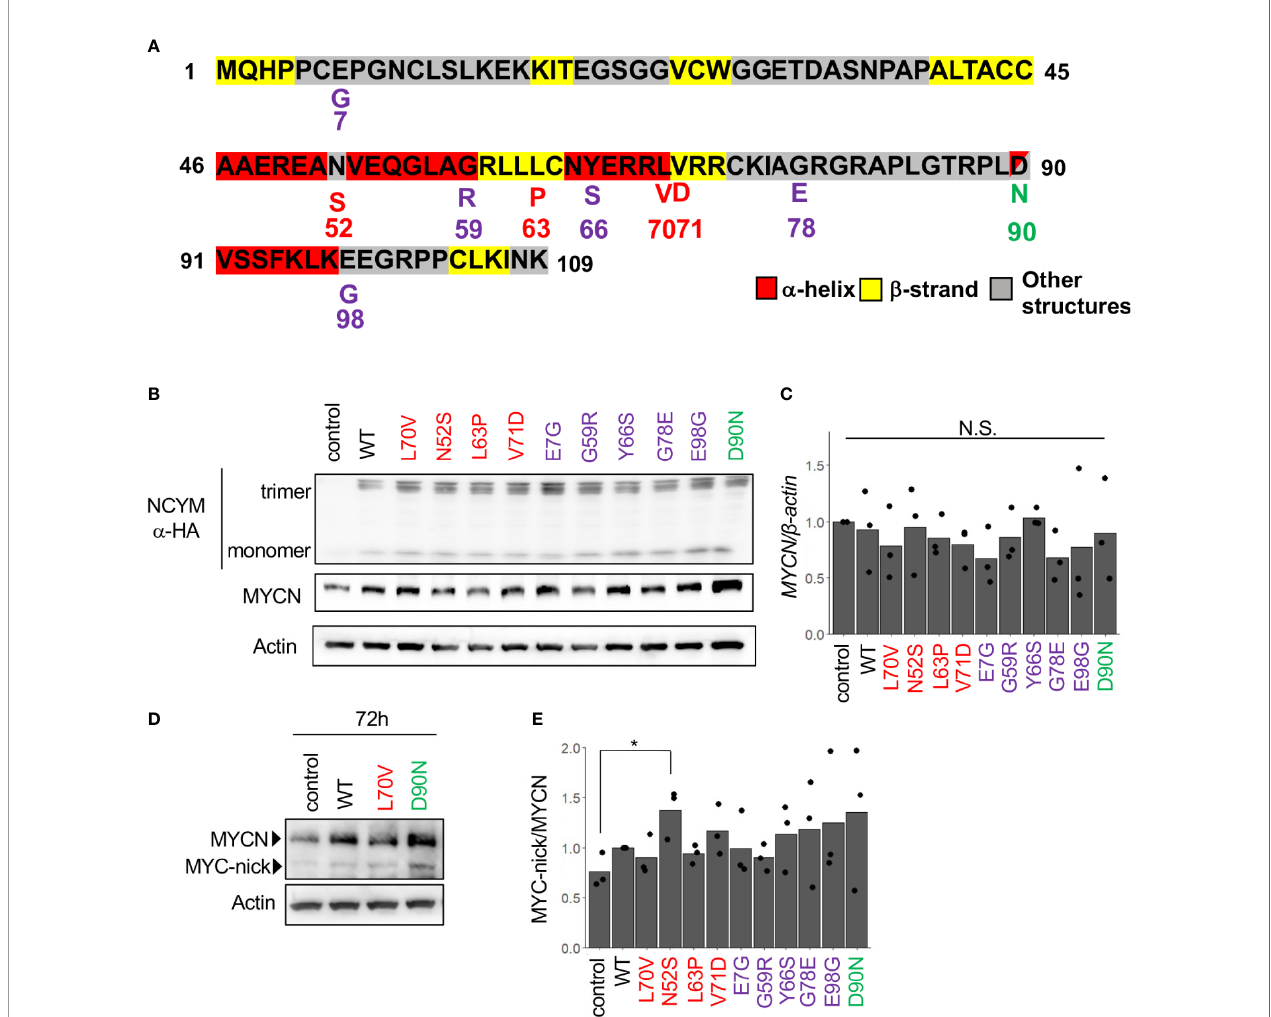
FIGURE 2 | MYCN stabilization and Myc-nick production by each NCYM variant. (A) NCYM amino acid sequences. Purple, variants found in chimpanzees; red, variants found in humans; green, D90N, a mutant of NCYM in which the 90th aspartic acid is substituted with asparagine. (B) Western blotting of HA-NCYM, MYCN proteins in NCYM SNP plasmid-transfected SH-SY5Y cells. At 24 h after transfection, the cells were subjected to western blotting. Actin was used as a loading control. Control: empty vector. (C) Quantitative real-time RT-PCR analyses of MYCN in NCYM SNP plasmid-transfected SH-SY5Y cells. At 24 h after transfection, mRNA expression levels were measured by real-time RT-PCR with b -actin as an internal control. N.S., not signi fi cant. Data were analyzed using Student ’ s t test (comparison with control). (D) Western blotting of MYCN and Myc-nick proteins in NCYM SNP plasmid-transfected SH-SY5Y cells. At 72 h after transfection, cells were subjected to western blotting. Actin was used as a loading control. (E) Quanti fi cation of western blotting analysis of NCYM SNP plasmid-transfected SH-SY5Y cells. At 72 h after transfection, the cells were subjected to western blotting. Myc-nick level was normalized to MYCN level. Data are shown as plots and means of three independent experiments. *p < 0.05. Data were analyzed using Student ’ s t test (comparison with